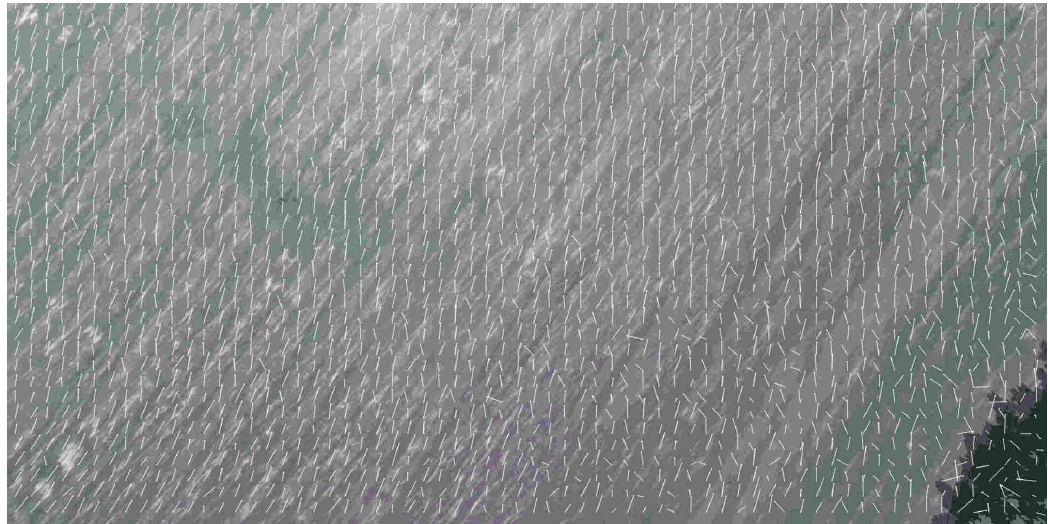
Figure 5. Optical flow estimated by Lucas-Kanade algorithm at the beginning of glissade, height ≈ 200 m, level of averaging 2 × 2. One can observe a rather regular nature of the optical flow which permits to estimate the flight parameters of the unmanned aerial vehicle with more or less high